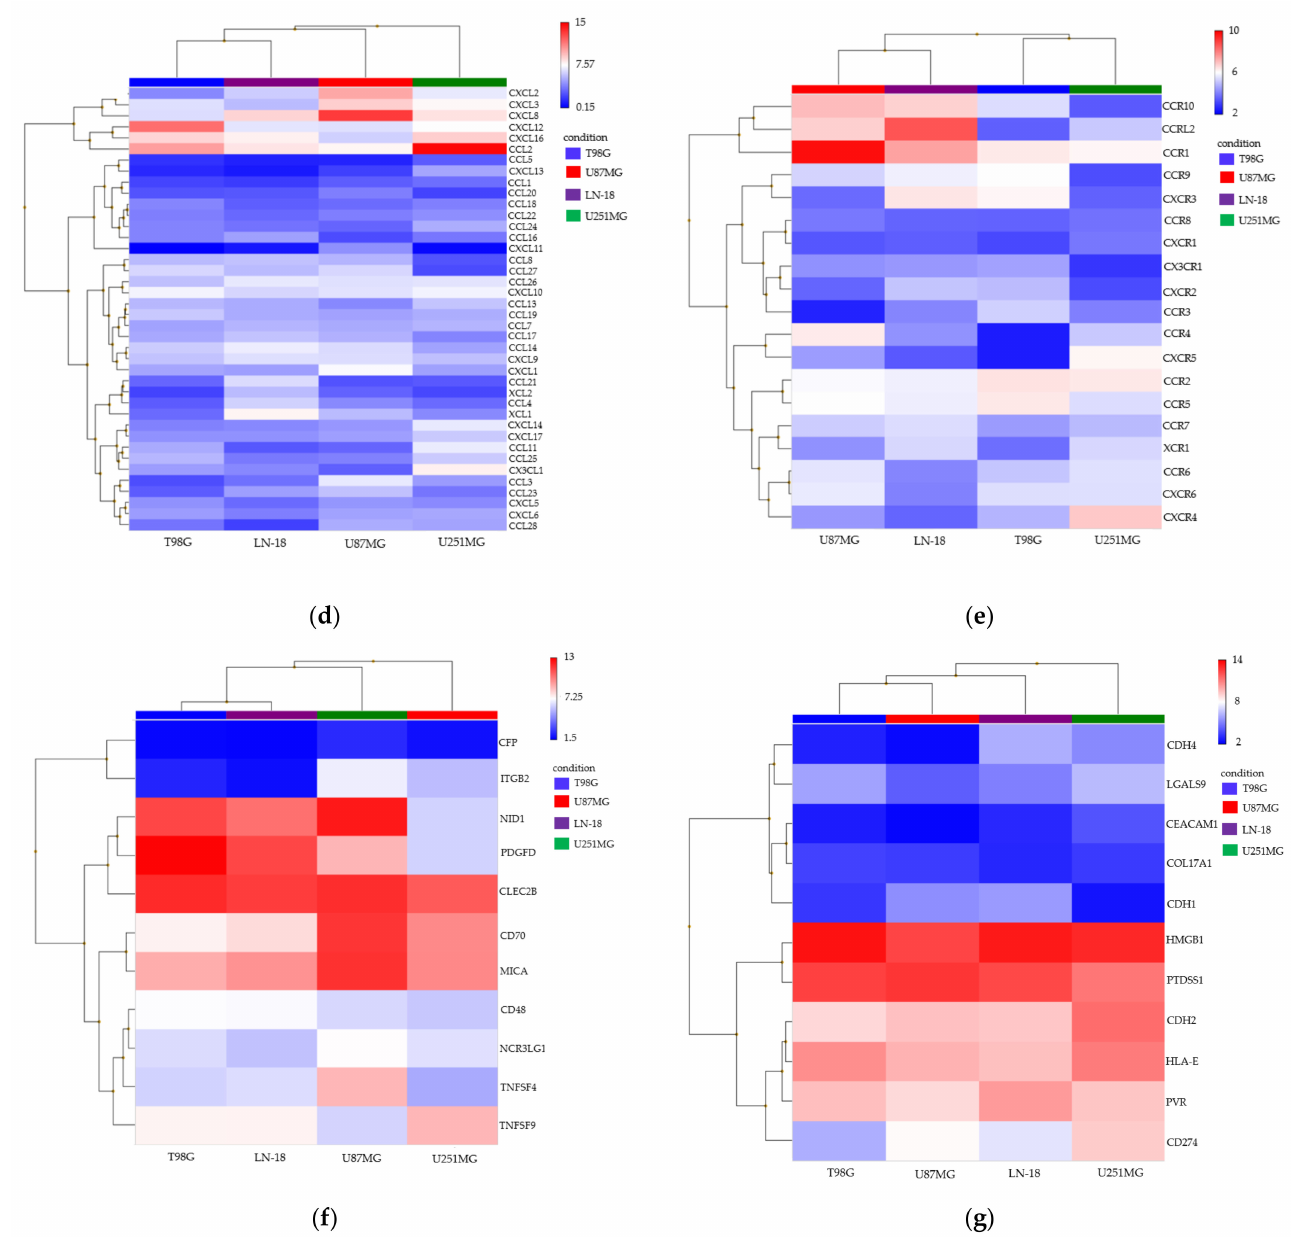
Figure 2. Hierarchical clustering of gene expression in monolayer-culture LN-18, T98G, U87MG, and U251MG GBM cell lines. ( a ) Morphology of each GBM cell line in monolayer-culture conditions; scale bar = 500 µ m. ( b – g ) The heatmaps of the transcriptome-wide Clariom™ S array of gene expression related to GSC markers ( b ), ECM markers ( c ), chemokines ( d